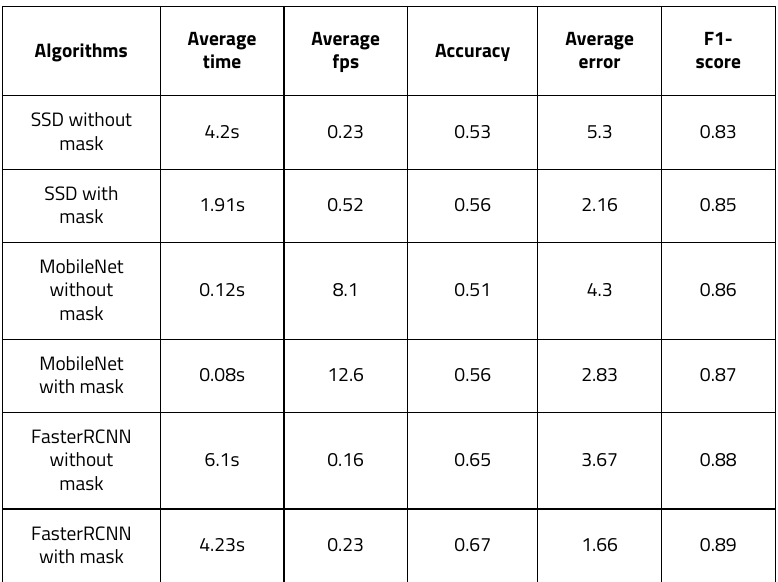
Figure 25. Time and accuracy measurement of different frameworks.